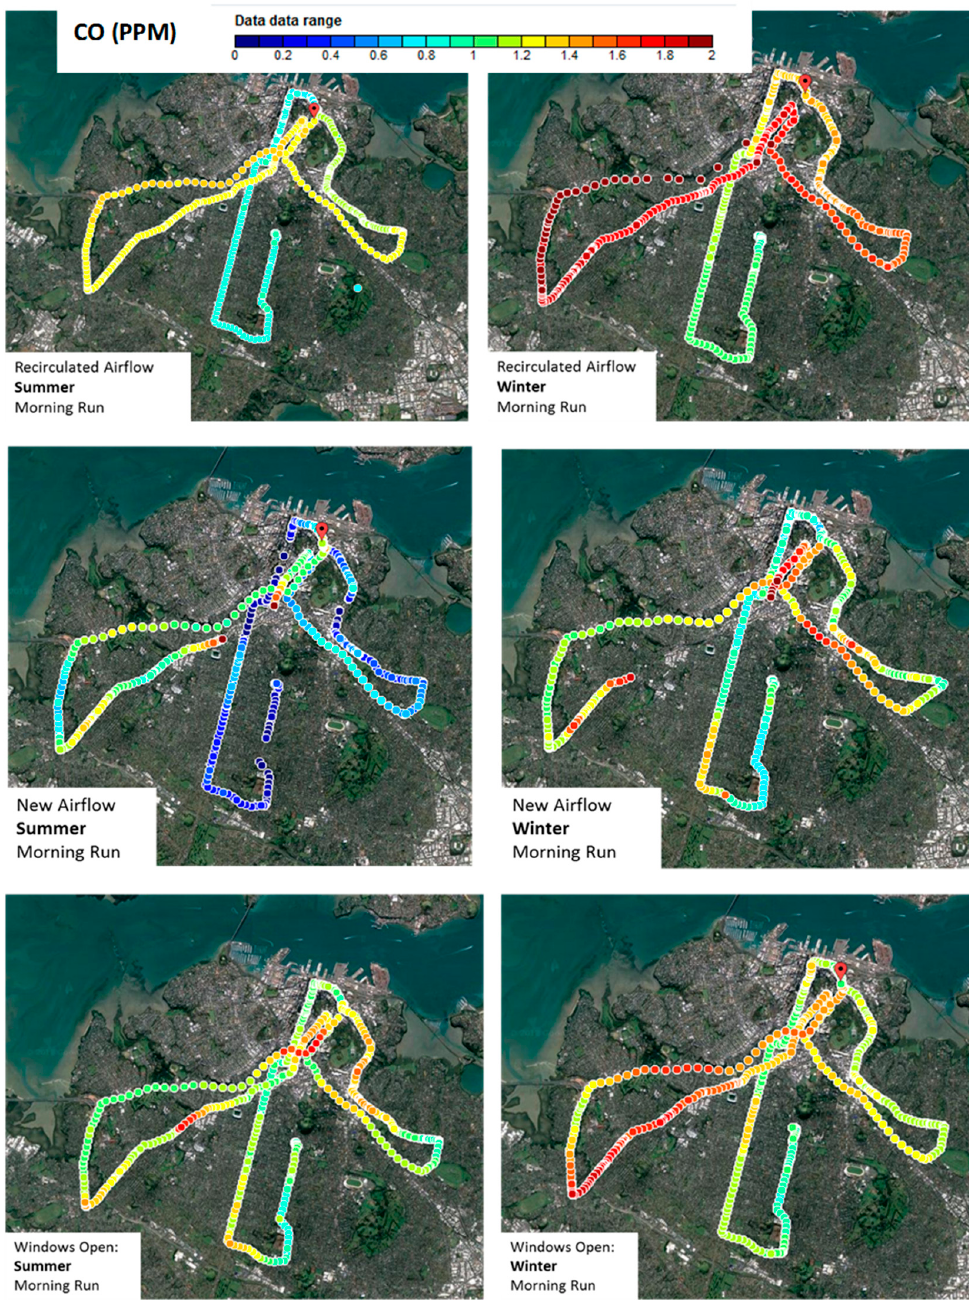
Figure 3. Morning 10-s averaged CO concentrations. Data from the summer on the left and winter on the right. The ventilations settings are: “Recirculate” ( top ), “new air” ( middle ), and “windows open” ( bottom ). The CO ppm range is shown in the legend at the top of the first graph and is consistent throughout the three graphs.